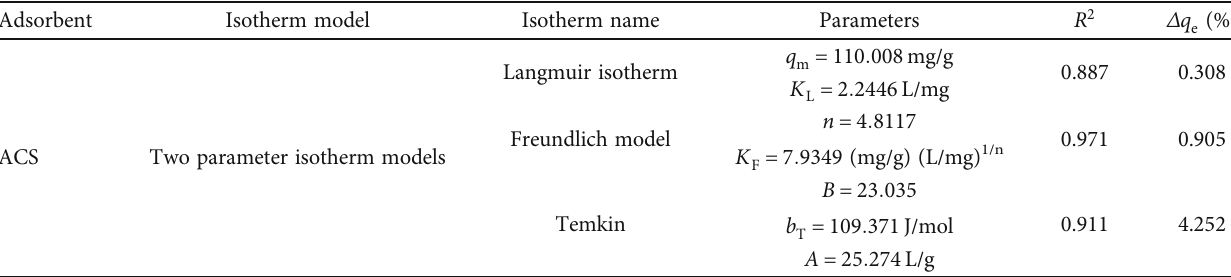
Table 2: Adsorption isotherm pertaining to CPF interaction with